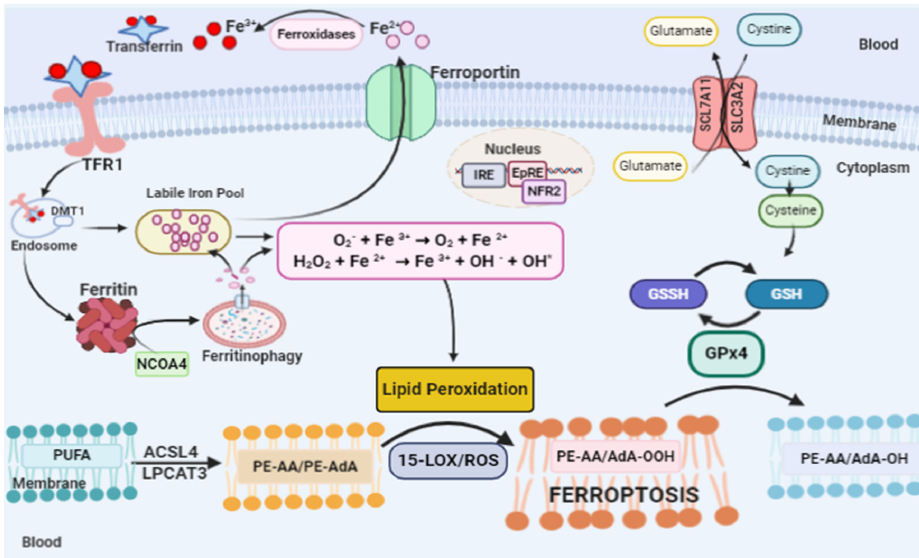
Figure 1. Ferroptosis pathway. Ferroptosis can be initiated through transferrin endocytosis linked